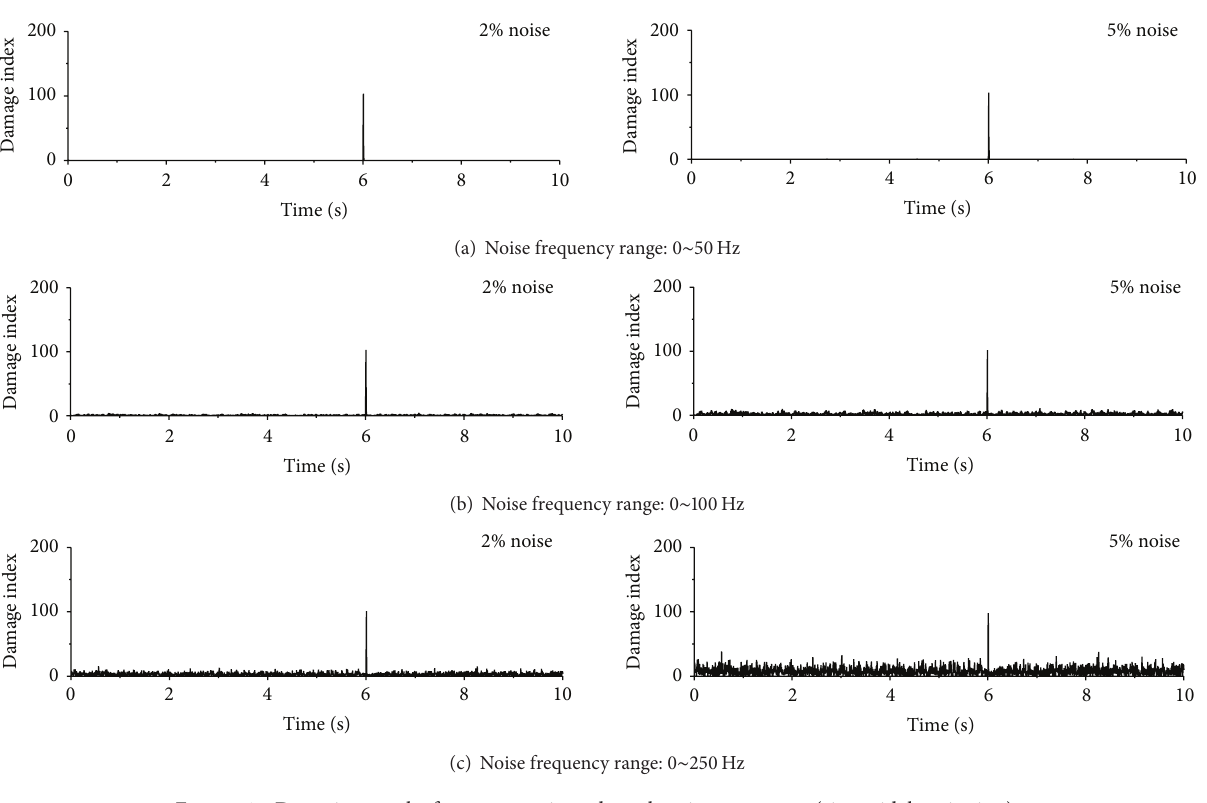
Figure 15: Detection results from contaminated acceleration responses (sinusoidal excitation).